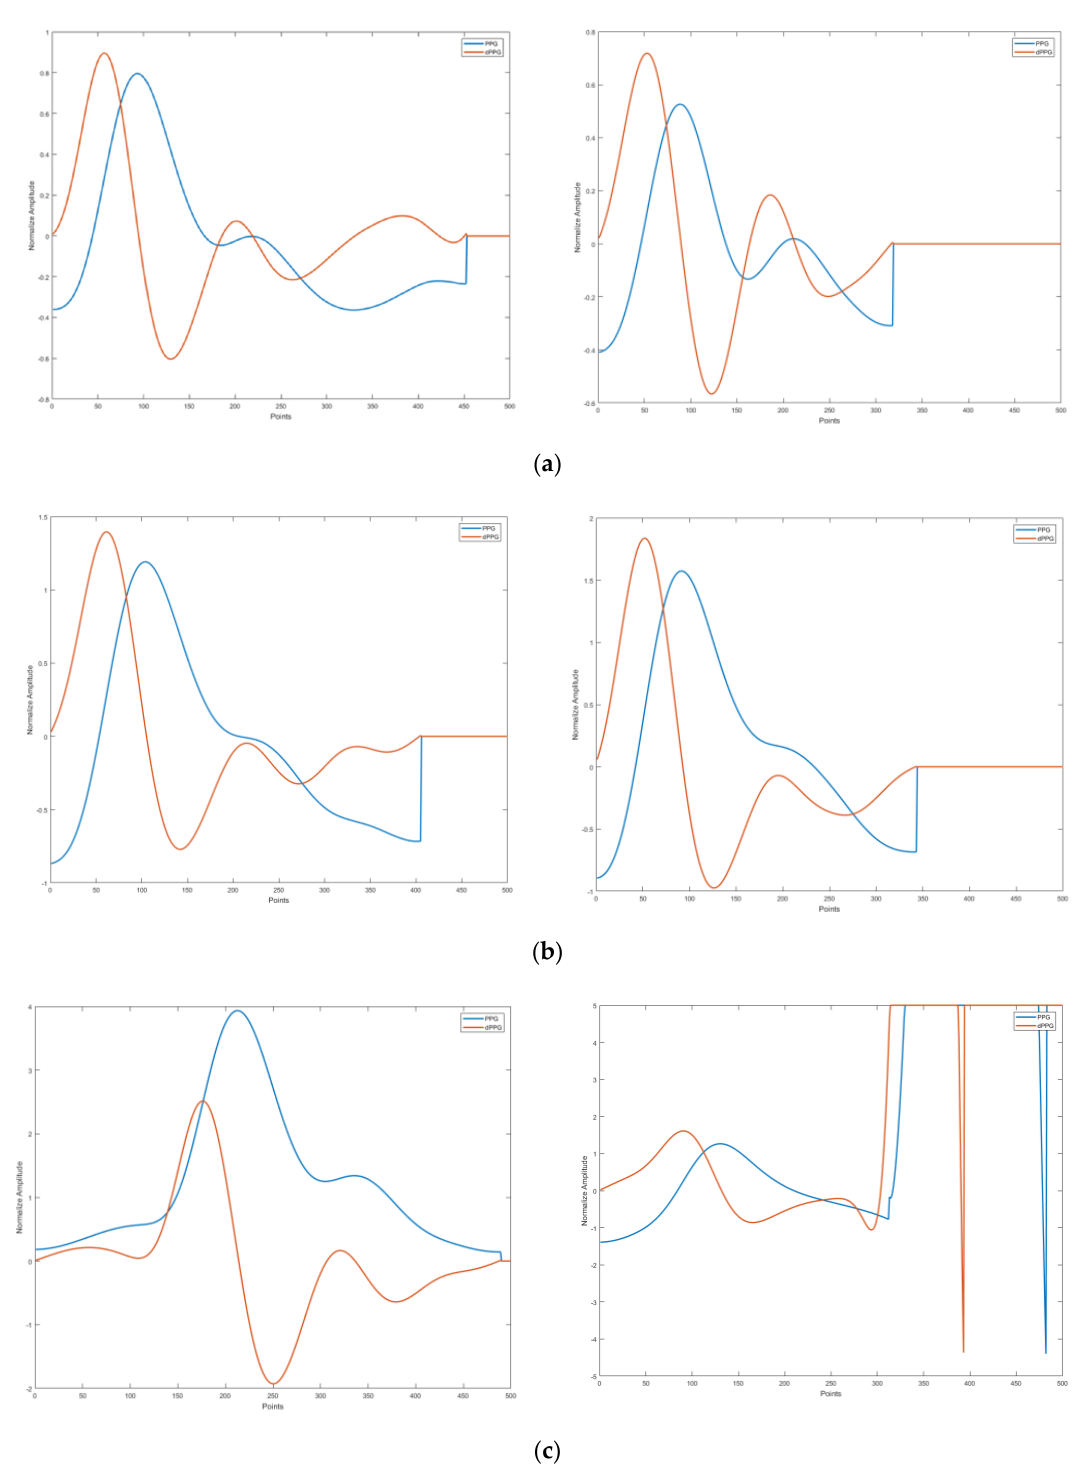
Figure 5. PPG (blue line) and DPPG (orange line) pulses with different quality levels. ( a ) High quality, ( b ) middle quality, ( c ) low quality.